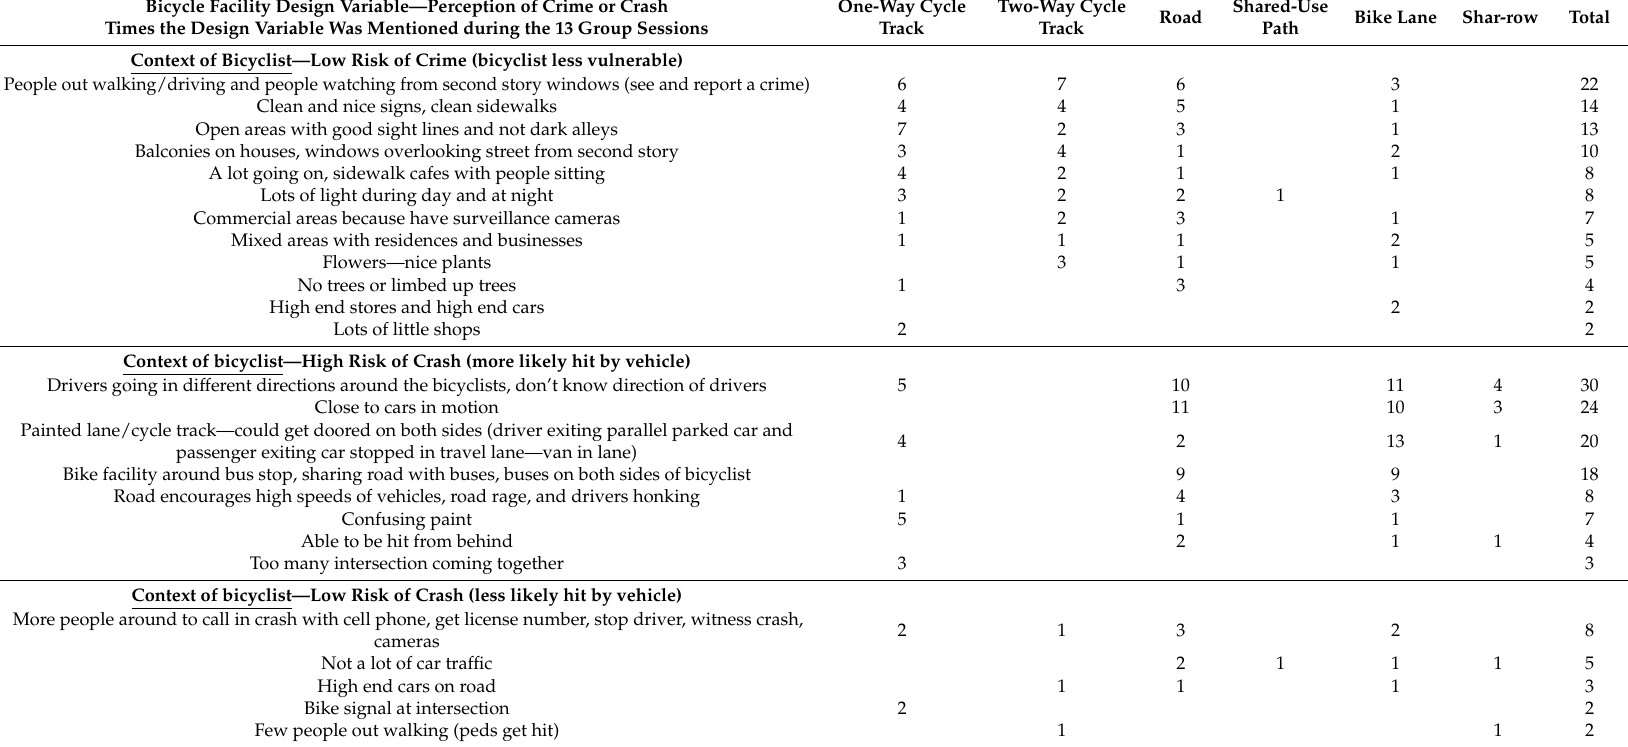
Bicycle Facility Design Variable—Perception of Crime or Crash Times the Design Variable Was Mentioned during the 13 Group Sessions